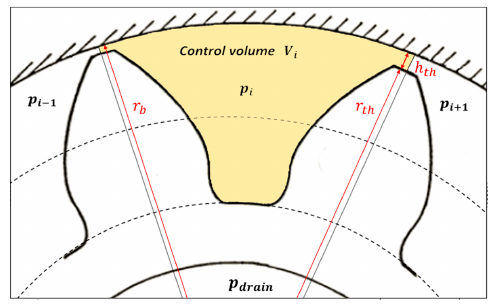
Figure 2. Control volume considered for continuity equation application.